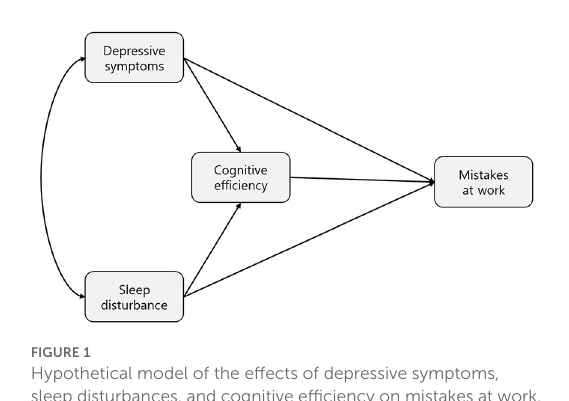
FIGURE1 Hypothetical model of the effects of depressive symptoms, sleep disturbances, and cognitive efficiency on mistakes at work. The hypothetical model includes four variables: depressive symptoms, sleep disturbances (predictor variables), mistakes at work (response variable), and cognitive efficiency (mediator